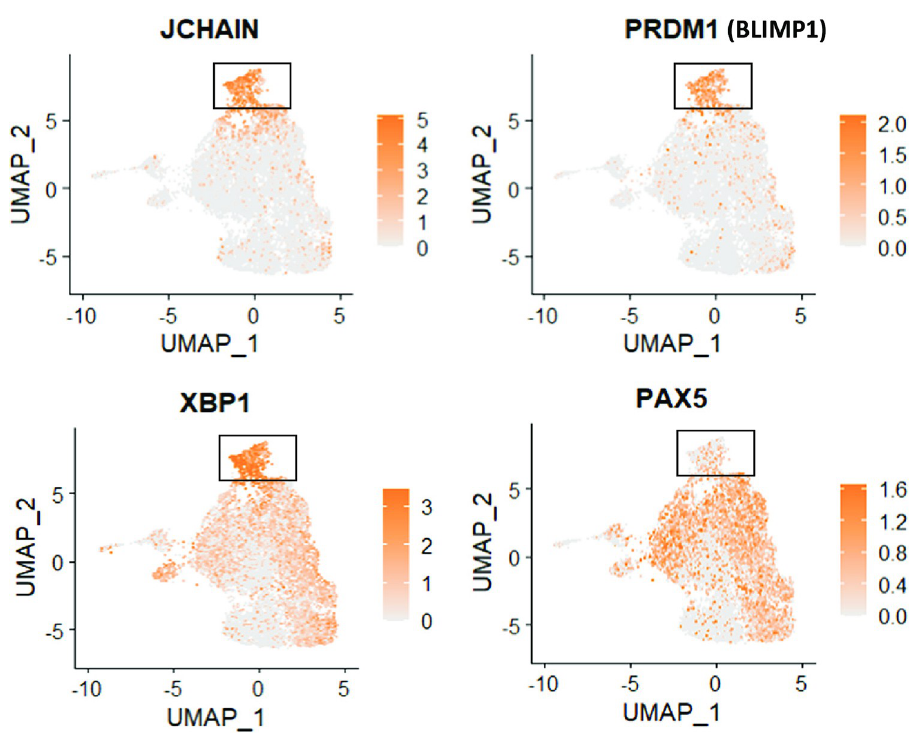
Fig 15. Gene expression analyses of Cluster 6. Cluster 6, which was found to be enriched within the type 2 sample ( Figs 11 and 12 ), has a gene expression signature of plasmablast-like cells (J chain, PRDM1, and XBP1 positive, and PAX5 negative).